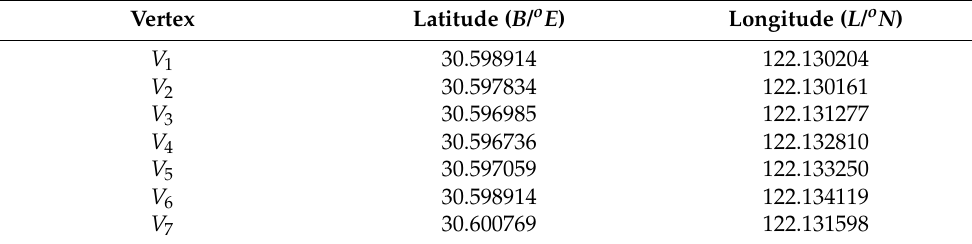
Table 1. Geodetic coordinates of the vertex of detection area 1.